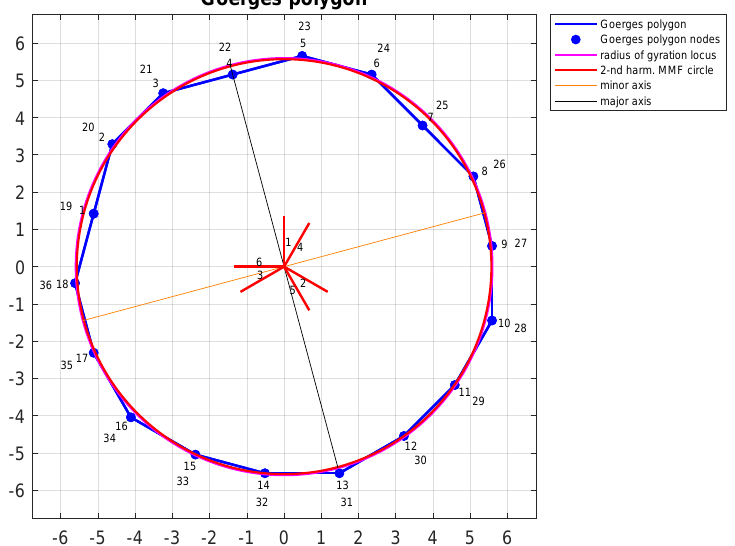
Figure 9. Goerges polygon for a six-phase machine with N = 36, p = 2 and y =